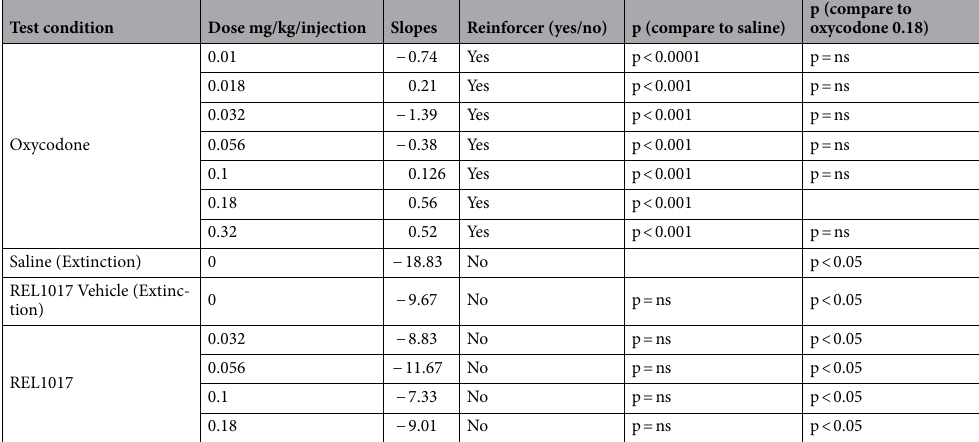
Table 3. Summary of the 3 day-to-day changes with corresponding slopes of regression